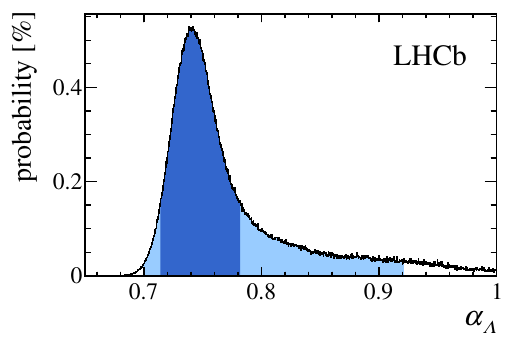
Figure 7 . Posterior probability distribution for (cid:11) (cid:3) , assuming a uniform prior, with all external constraints removed. The shaded regions indicate the 68% and 95% credibility